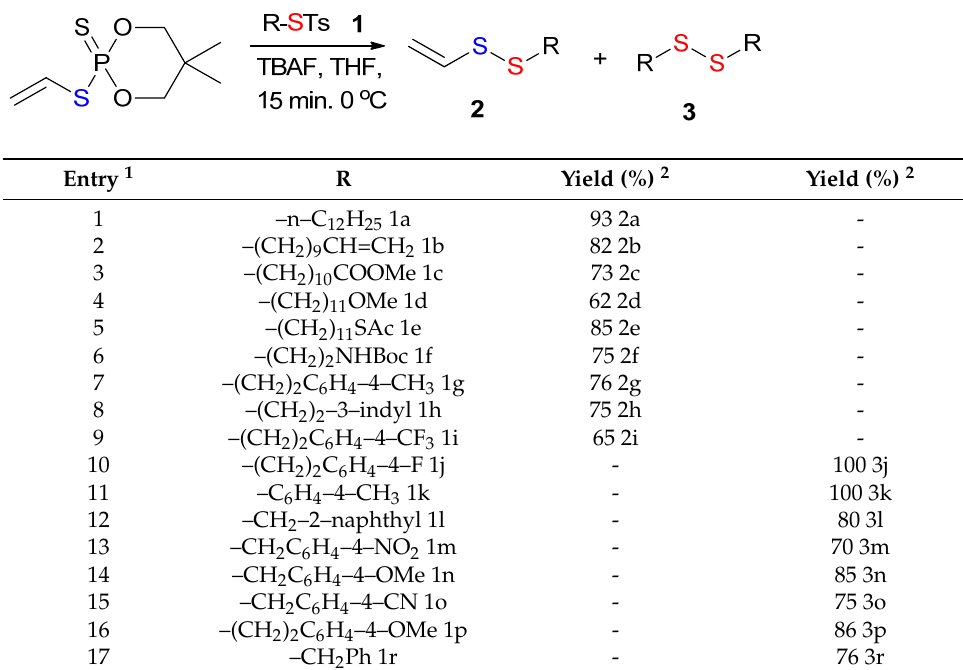
Table 1. Synthesis of vinyl disulfides 2 from S-vinyl phosphorodithioate.